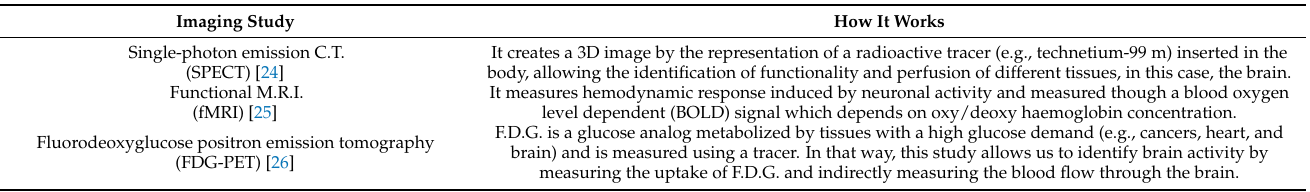
Table 5. Explanation of Imaging